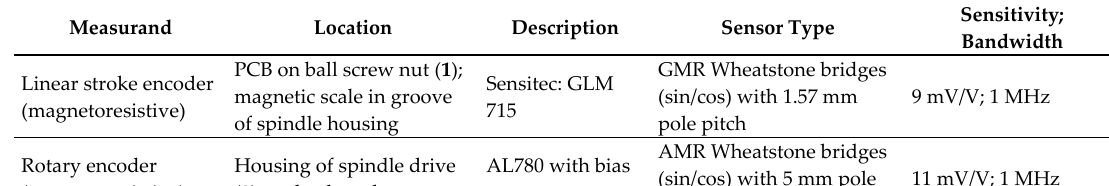
Table 1. Sensors used in integrated sensor system.